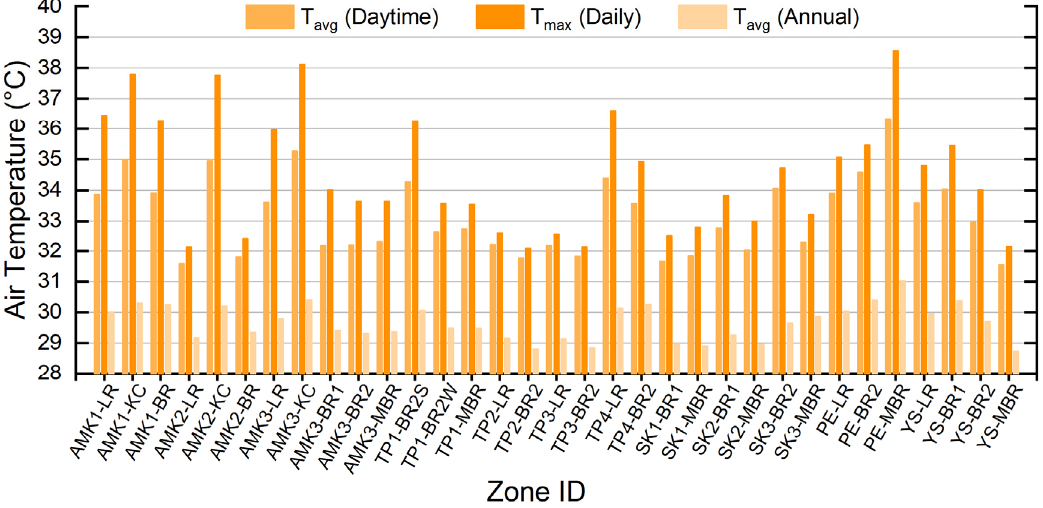
Figure 10. Average and maximum T a in target zones for window closed